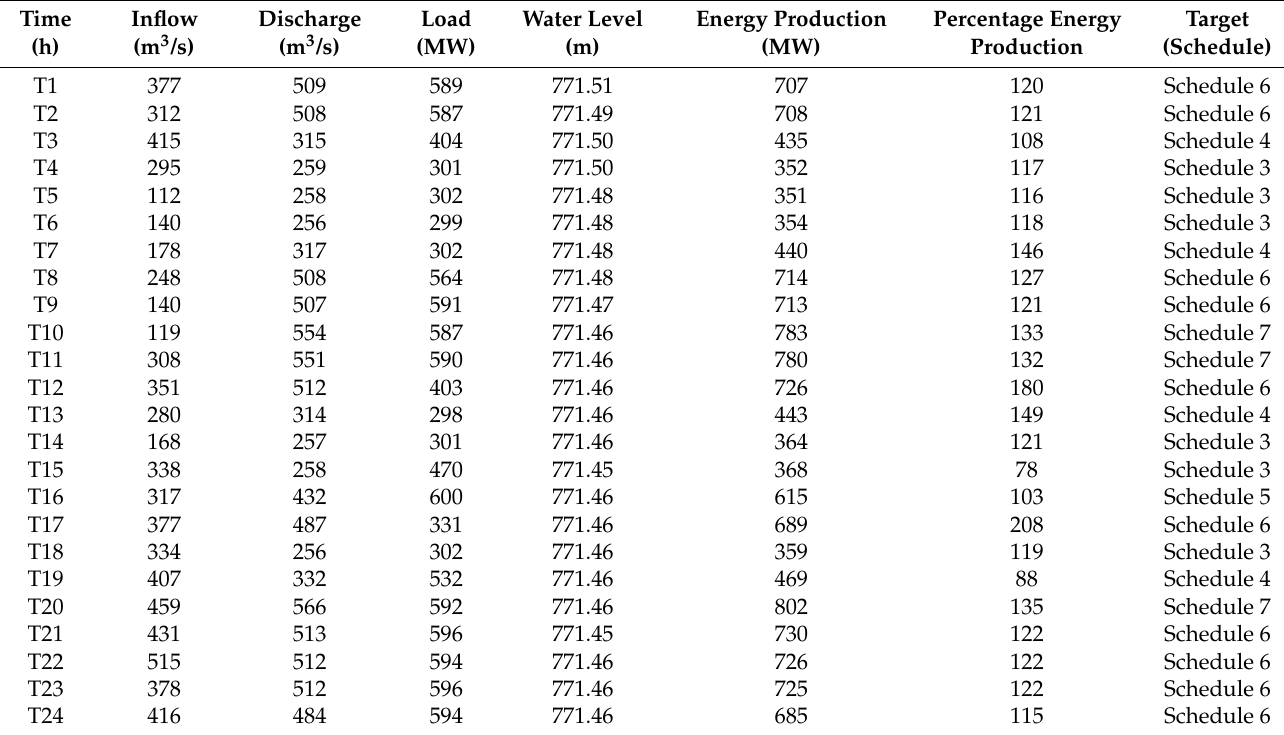
Table 1. Data set of Tianshengqiao plant 1 for the winter season.